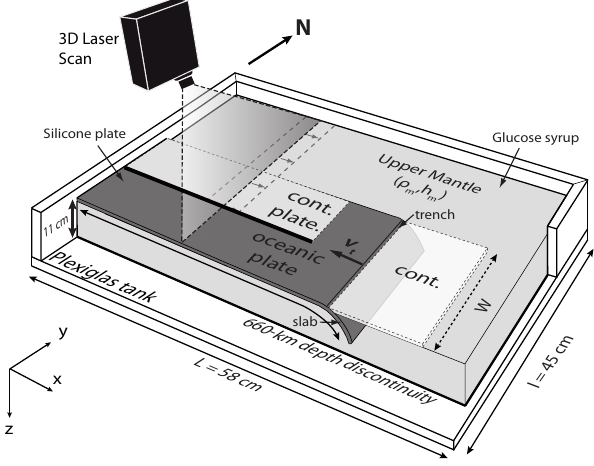
Fig. 2. Experimental setup. The subducting lithosphere is modelled by a silicone plate made of two different materials, a positively buoyant one (defined as continental lithosphere) and a negatively buoyant one (defined as oceanic lithosphere). The upper mantle is simulated by means of glucose syrup, the bottom of the box corre- sponding to an impermeable lower mantle-upper mantle disconti- nuity. The plate is fixed , i.e. its trailing edge is attached to the box. The surface topography is monitored by a 3-D laser scan and pic- tures are taken from the top and the side of the model every 30s. See Table 1 for experimental